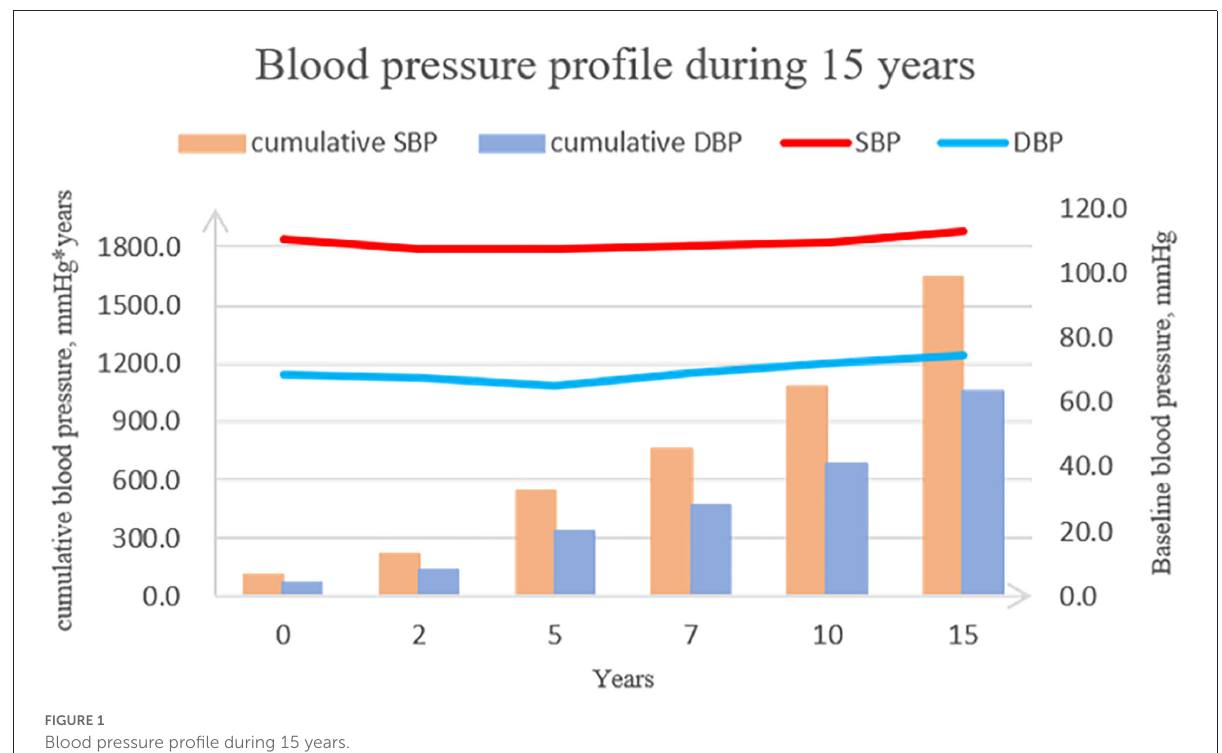
FIGURE1 Blood pressure profile during 15 years.